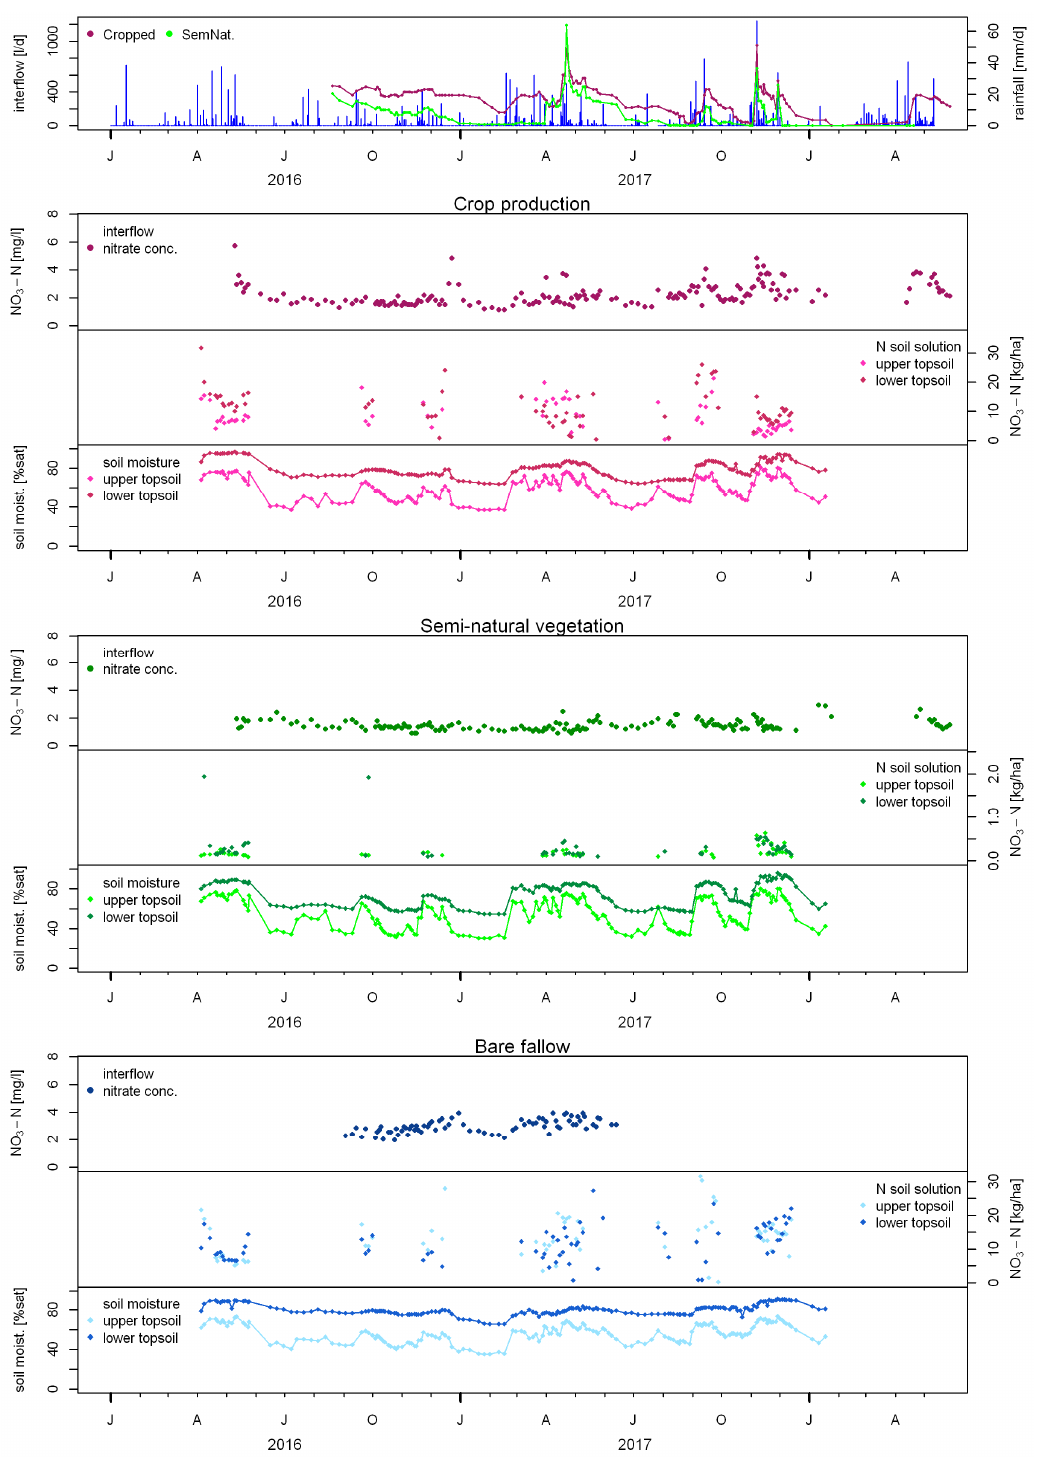
Figure 7. Interflow volumes from the plots under crop production and semi-natural vegetation, as well as rainfall (first panel). Panels two to four show the nitrate concentration in the interflow [mg NO 3 -N/L, mean nitrate content in the soil solution along the slope in the upper and lower topsoil [kg NO 3 -N/ha], and mean soil moisture [% sat.] along the slope in the upper and lower topsoil at the plot under crop production (second panel), the plot under semi-natural vegetation (third panel), and the plot under bare fallow (fourth panel). Timeline labeling “J A J O” refers to January, April, July,